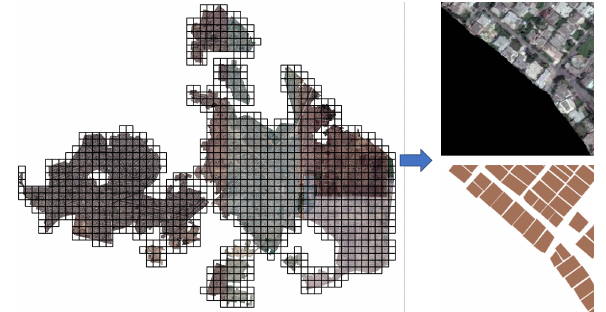
Figure 3. Tiling of Images. Here we show our process of ex- tracting images from Geo-tiff file. On left, grid of 300m x 300m is overlaid over the marked region. On the right, the extracted image (upper right) and it’s corresponding segmentation mask (lower right) from one of the tiles is shown. The black area shows the unmarked region. does not indicate whether a particular plot of land has construc- tion on it.